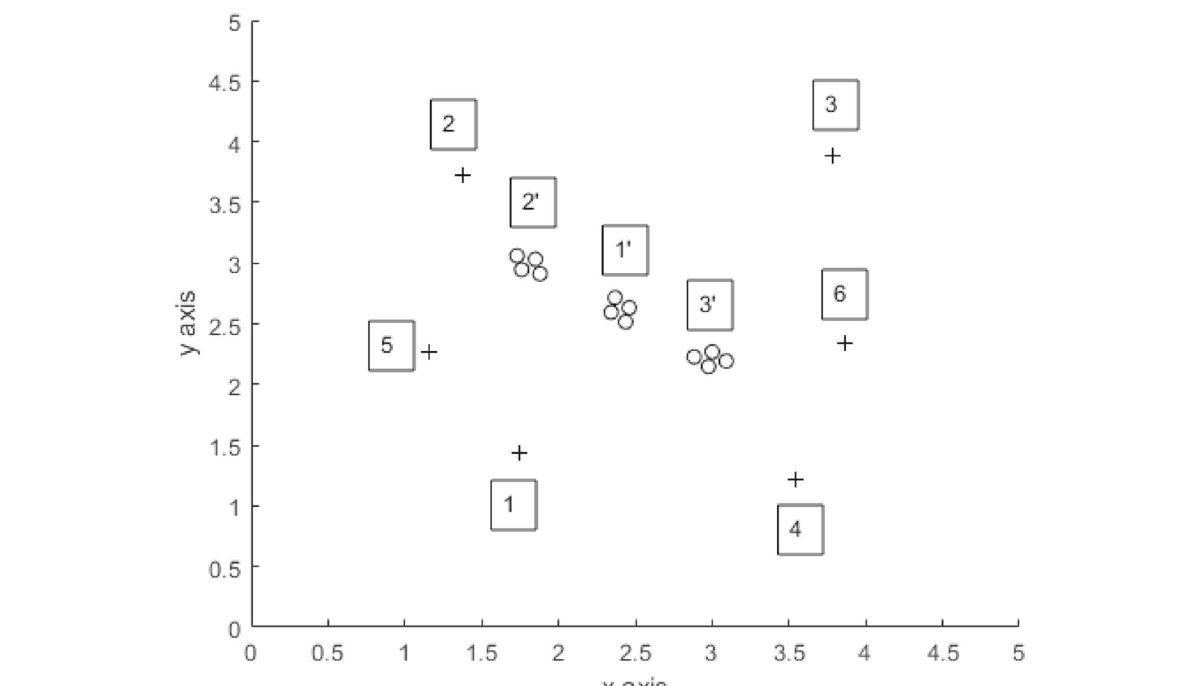
Fig. 6 Room setup for the comparison of the proposed and the naïve algorithms. The speakers are denoted by + and numbered by 1, ... ,6. The microphones are denoted by o . The arrays are numbered by tagged numbers 1 (cid:11) ,2 (cid:11) ,3